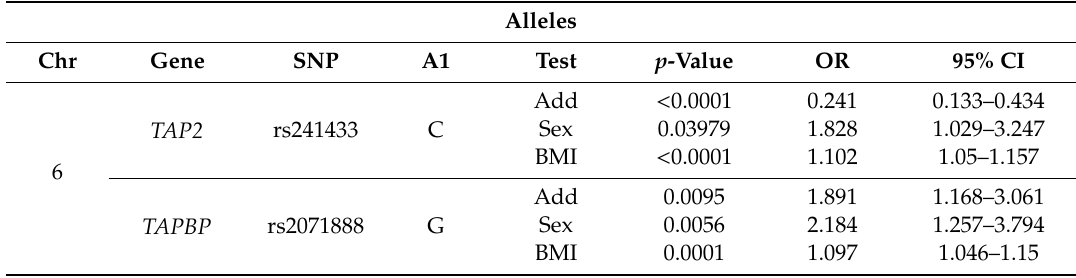
Table 3. Logistic regression analysis for single nucleotide polymorphisms (SNPs) associated with influenza A virus (IAV)